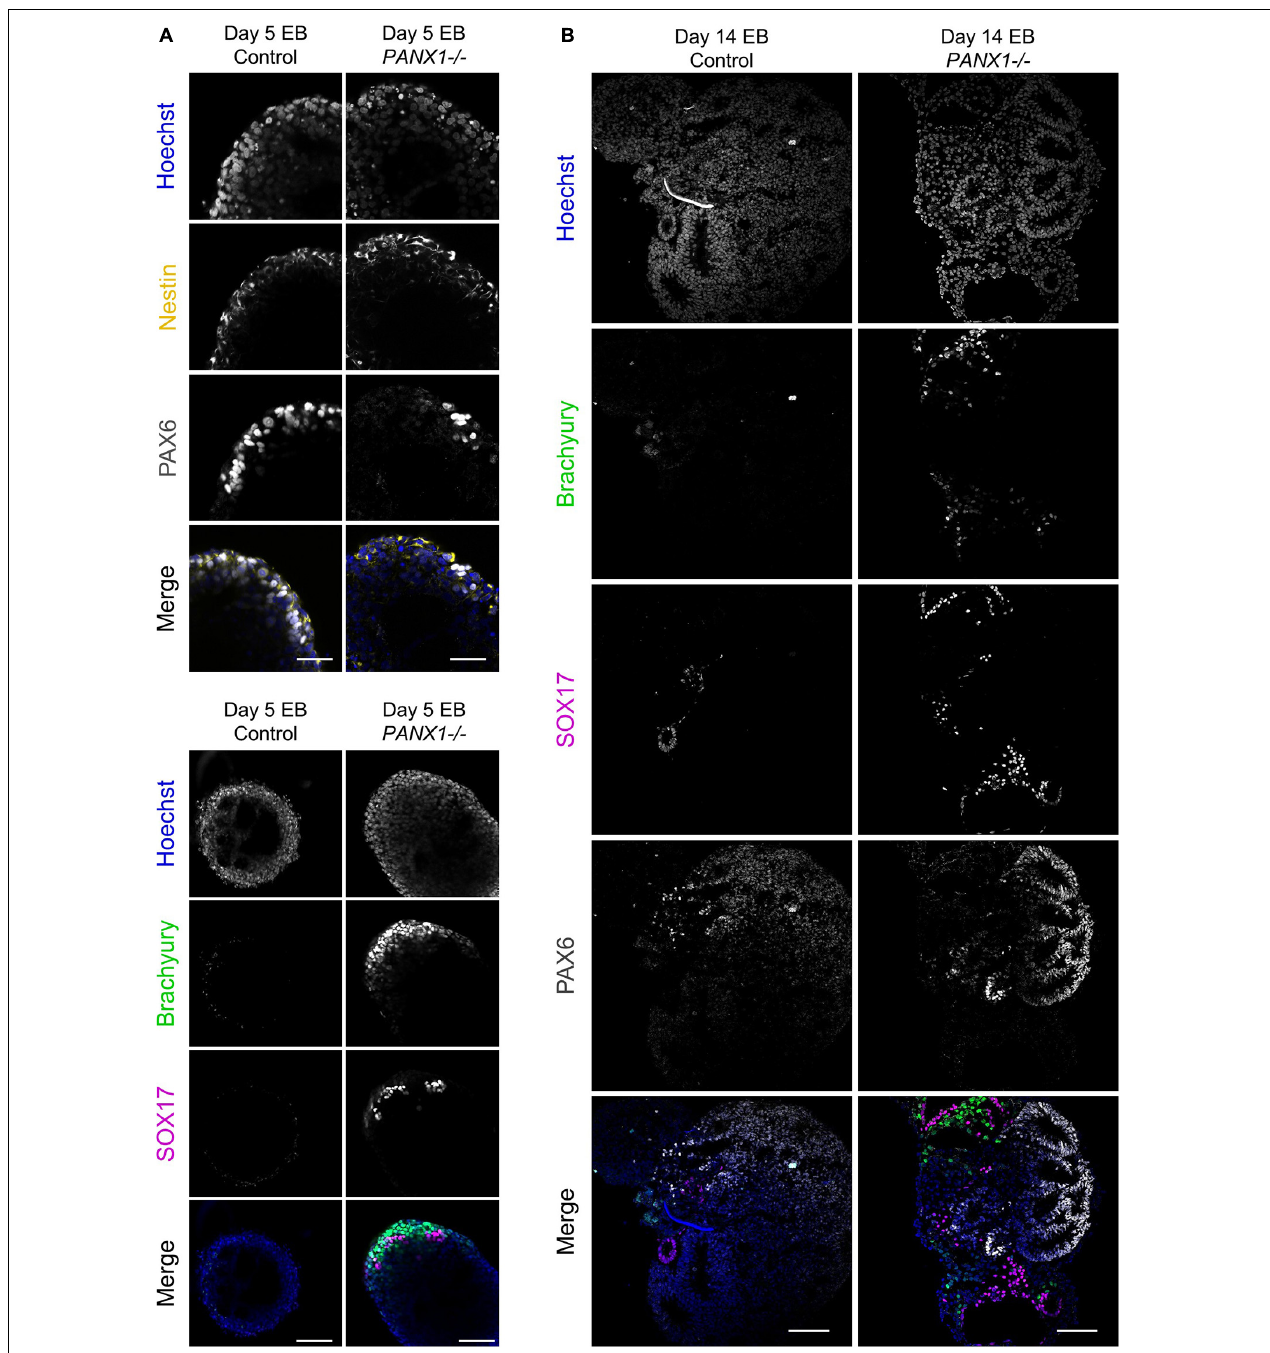
FIGURE 6 | Immunofluorescent analysis of PANX1-/- embryoid bodies. (A) Immunofluorescence of ectoderm (Nestin, yellow; PAX6, gray), mesoderm (Brachyury, green) and endoderm (SOX17, magenta) in control and PANX1-/- day 5 whole mount EBs. (B) After 14 days of differentiation, control and PANX1-/- EBs were cryosectioned and evaluated for germ lineage expression. Equal brightness contrast enhancements were made in FIJI for picture clarity. Nuclei (Hoechst, blue). Scale bar = 100 µ